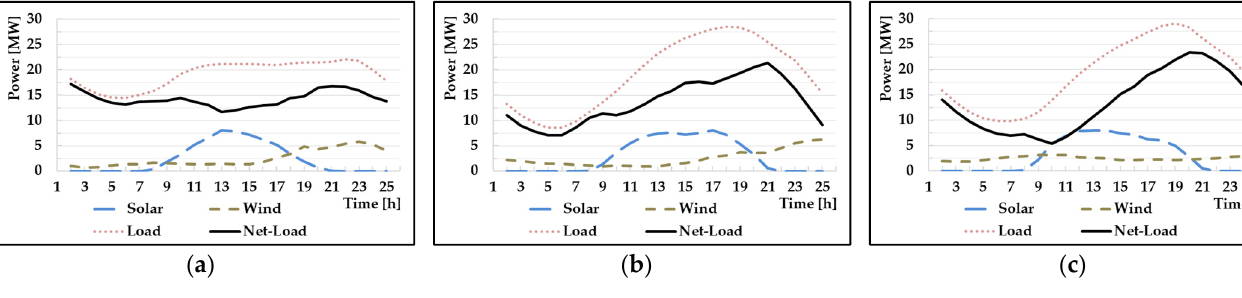
soe comparison of the three methods presented t